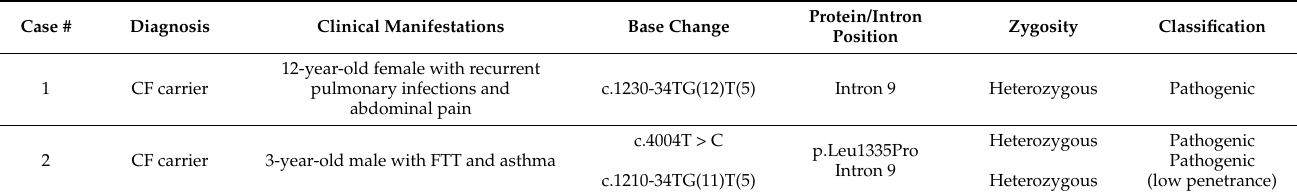
Table A1. Clinical manifestations and CFTR variants of 12 Puerto Rican